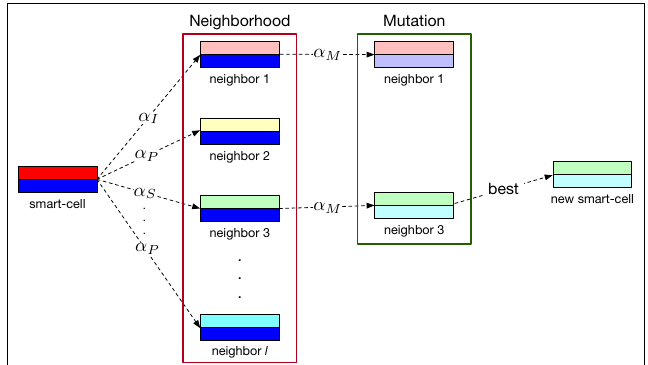
Figure 3. Global neighborhood for exploration of the search